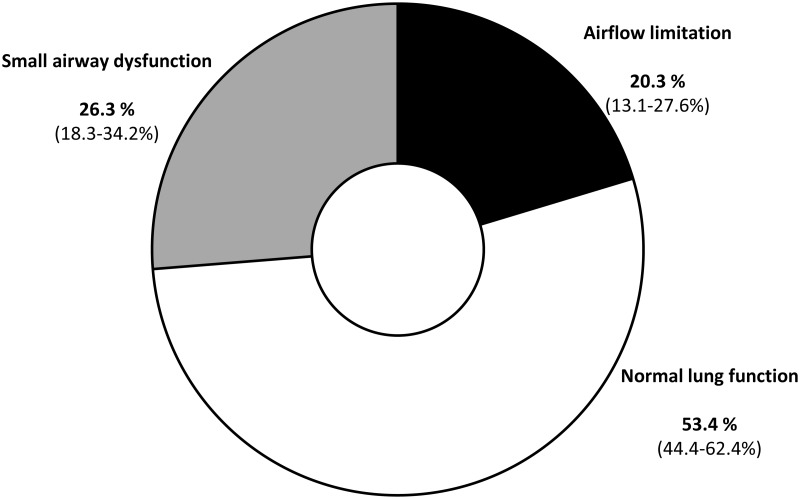
Prevalence of airflow limitation and small airway dysfunction in patients with ischemic heart disease.95% confidence intervals are shown in parentheses.